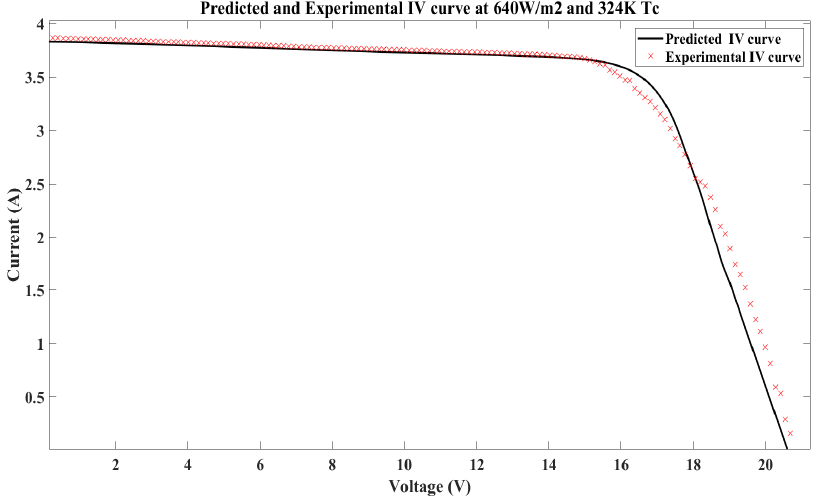
Figure 10. Predicted and experimental IV curves for polycrystalline module at 410 W/m 2 and 316 K T c .